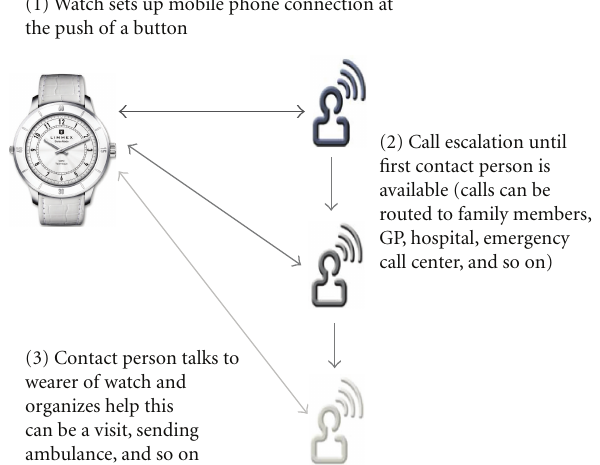
Figure 3: Limmex Emergency Watch—escalating alarm mecha-